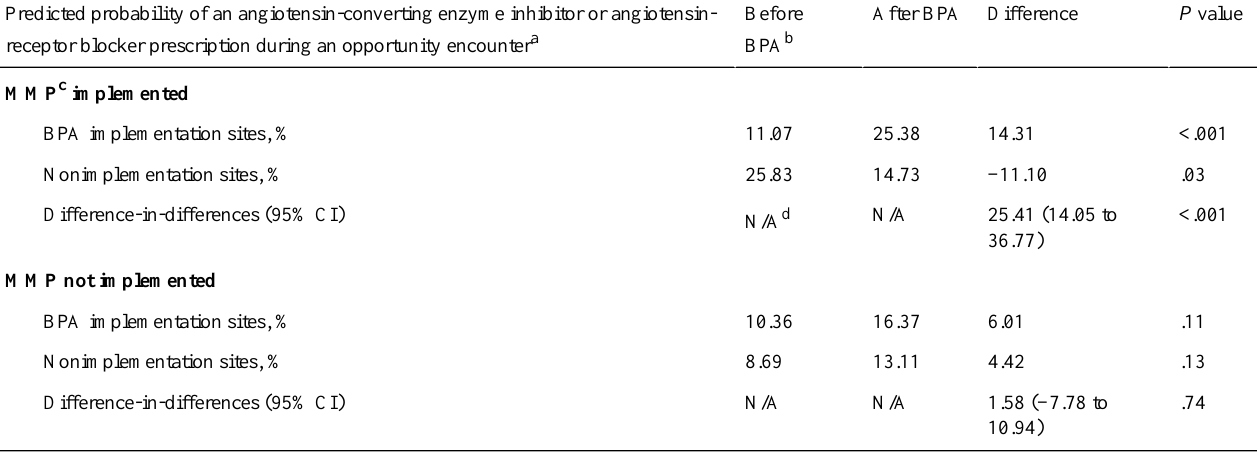
P valueDifferenceAfter BPABefore